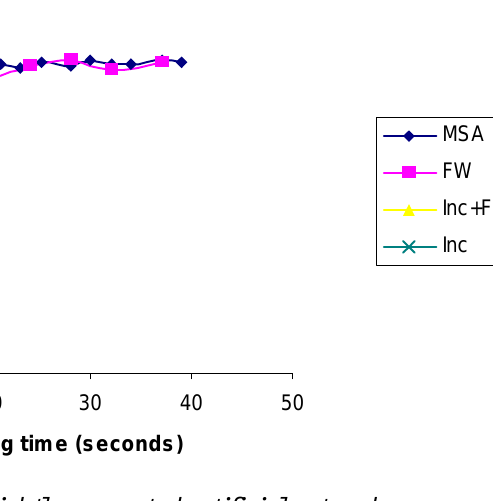
Figure 6. Assignment results on lightly congested artificial